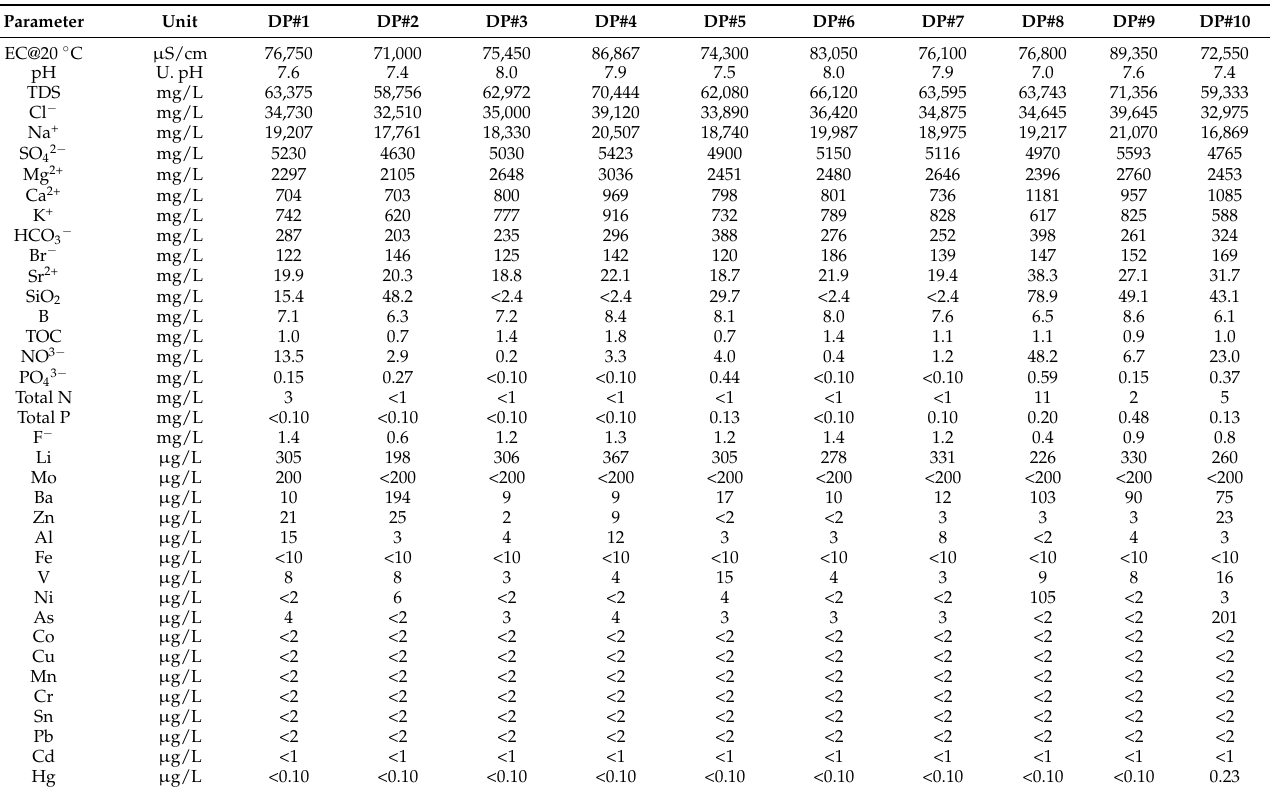
Table 4. Chemical composition of the brines from 10 desalination plants in the Canary